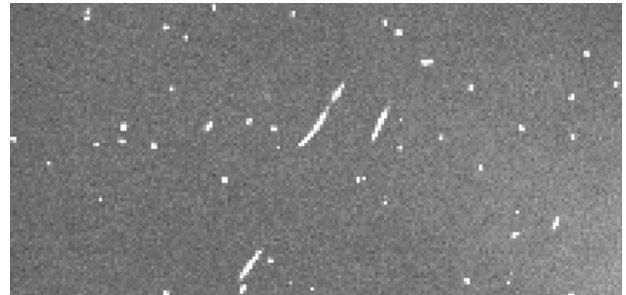
Fig. 10.— Traces of cosmic ray particles in an image taken with the Hubble Space telescope. Image credit: NASA and